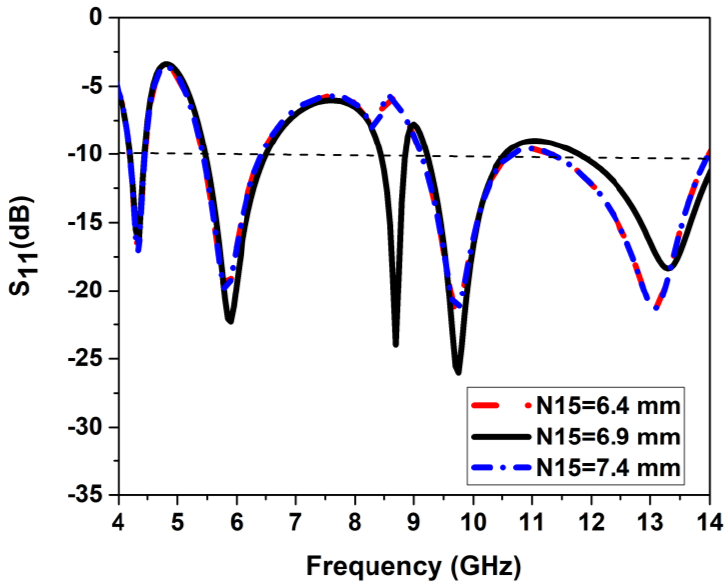
Figure 22. S 11 for variation of length ‘N15′ .